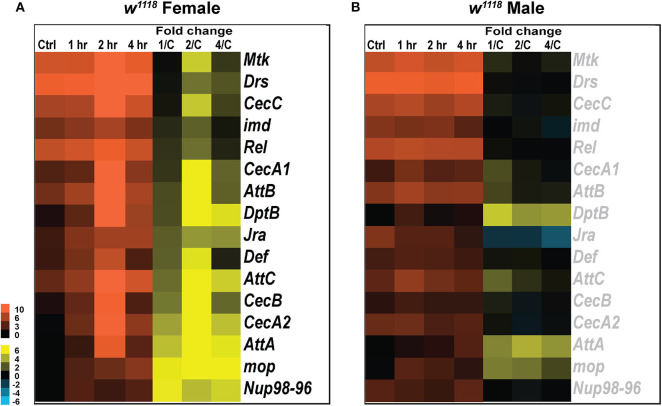
Immune gene expression changes in response to injury. Heatmaps depicting expression changes in immune function related genes for females (A) and males (B) at control, 1, 2, and 4 hr after injury. The orange scale represents average normalized counts for 3 replicates in each of the indicated groups. Yellow-blue scale shows fold change for each gene at 1, 2-, and 4-hr post-injury compared to control. 1/C, fold change at 1-hr compared to control; 2/C, fold change at 2-hr compared to control; and 4/C, fold change at 4-hr compared to control. All genes indicated in black font are significant (|log2FC| > 1, p < 0.05).